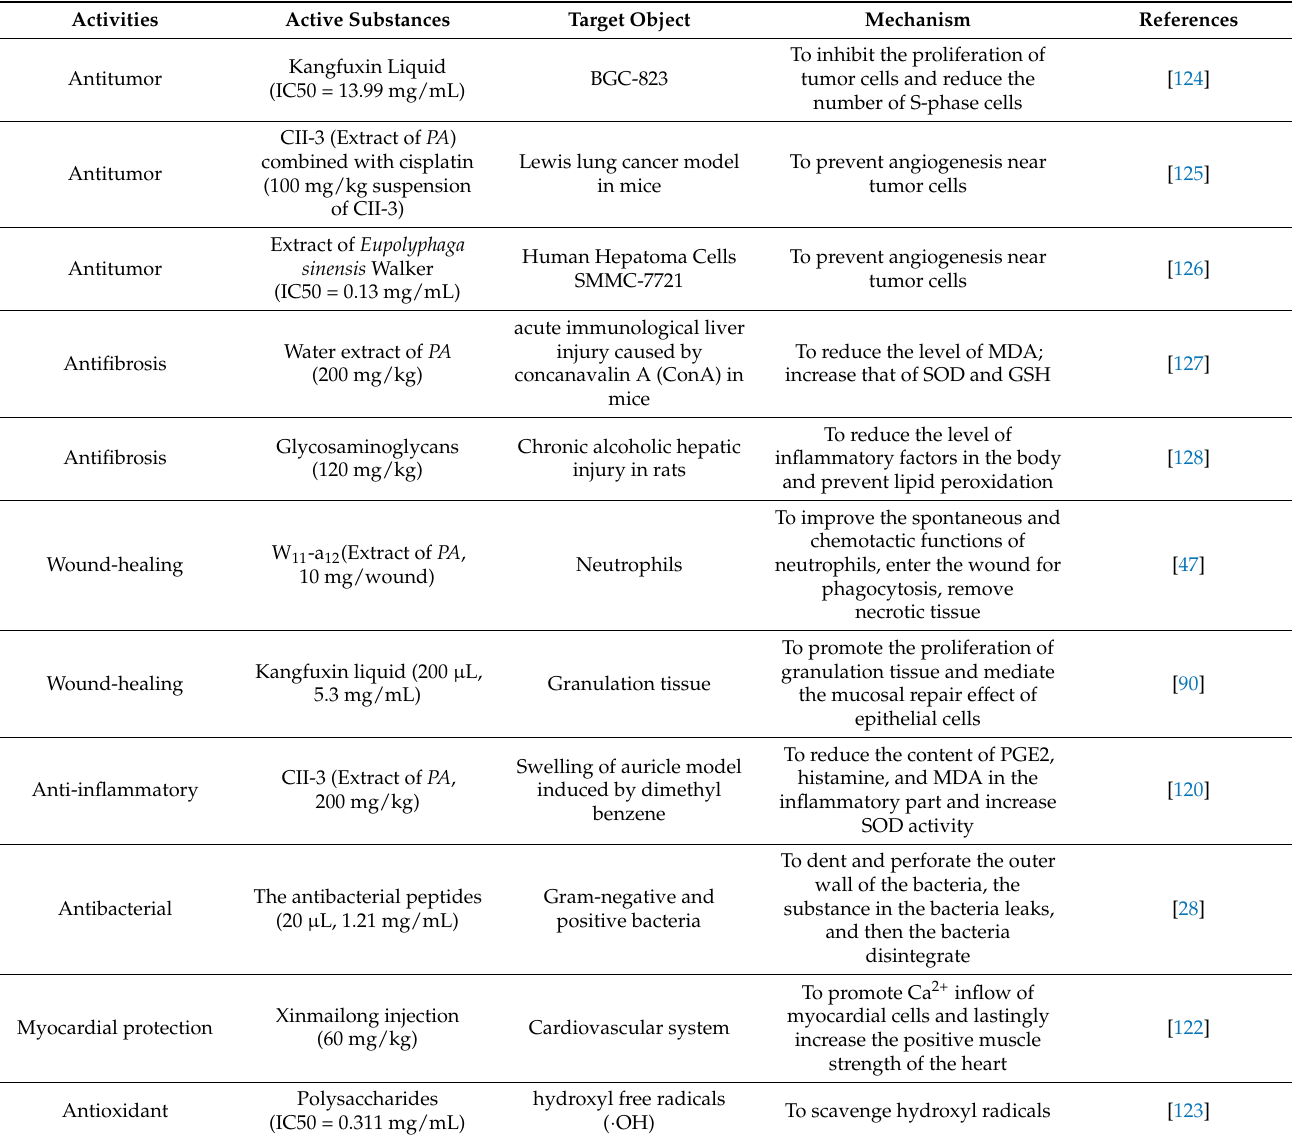
Table 3. Examples of pharmacological activities of the family